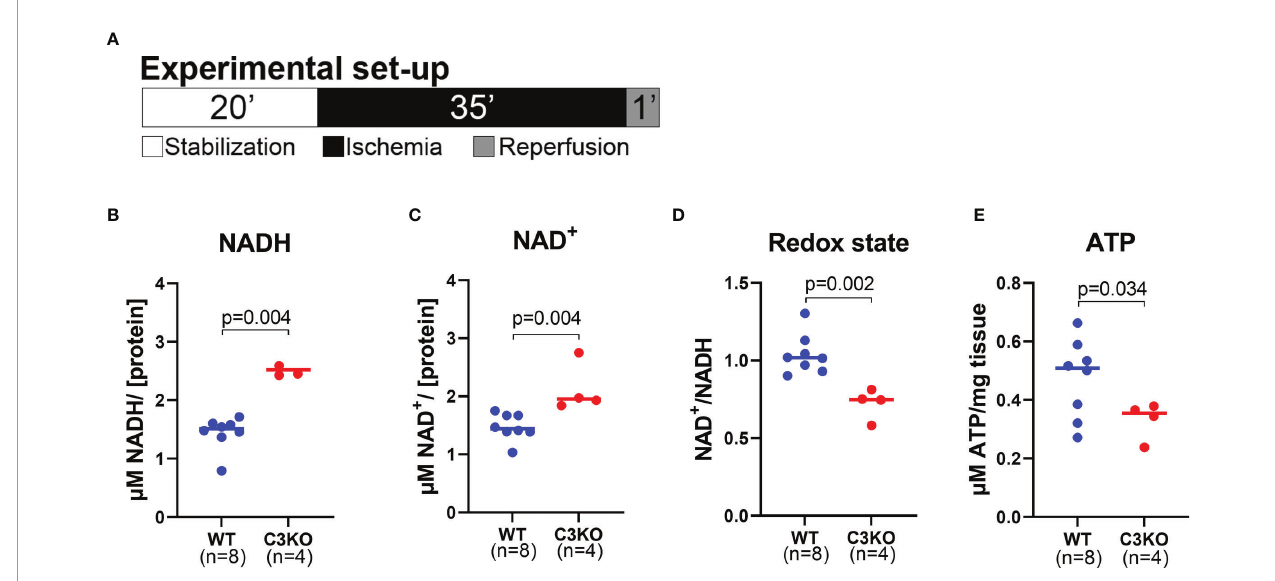
FIGURE 5 | Metabolites in mouse WT and C3KO hearts. Isolated hearts from wild type (WT) and Complement component 3 knock out (C3KO) were exposed to 20 minutes stabilization, 35 minutes ischemia, and 1 minute reperfusion (A) , and selected metabolites were measured by luminescence assays. (B) NADH, (C) NAD+, (D) NAD + /NADH ratio, and (E) ATP were quanti fi ed in heart tissue and normalized to protein concentration (B – D) or mg tissue (E) , n=4-8. Panel B and C did not pass normality test and are analyzed with a non-parametric Mann-Whitney t-test. Data sets are displayed as scatterplots with